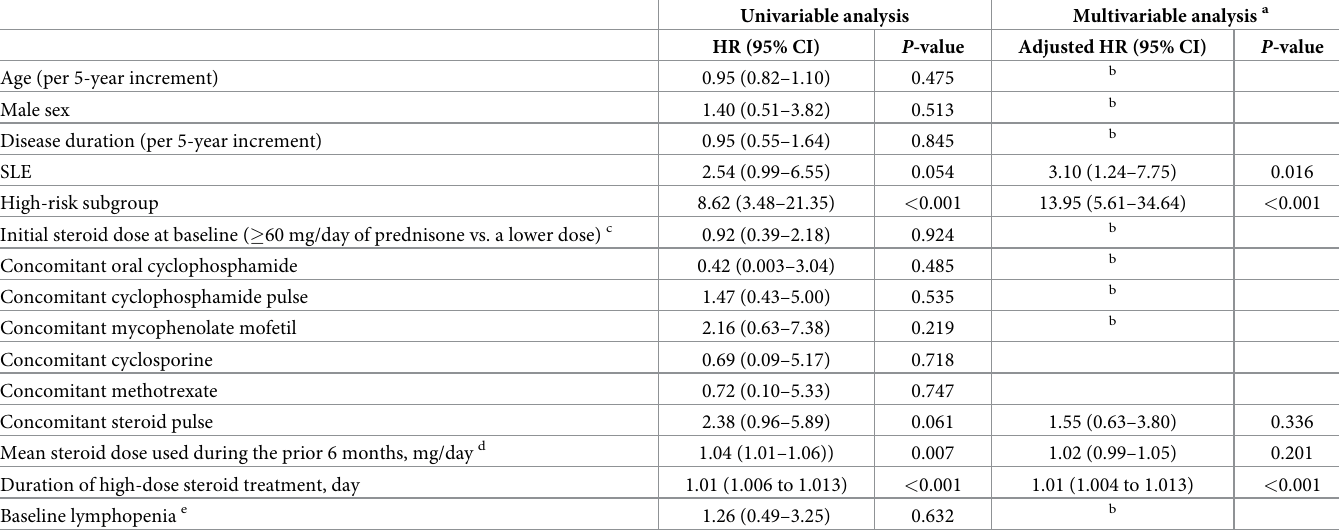
Table 2. Clinical factors associated with the 1-year TB incidence during the observation period.